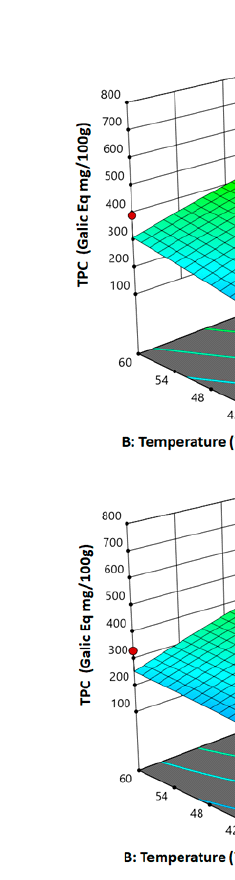
Figure 1. Three-dimensional response surface plot for “response” variable: (total phenolic content (TPC)), as a function of WAE “factors”: temperature, time, and rotation in two date palm fruits cultivars, Anbara and Reiziz.